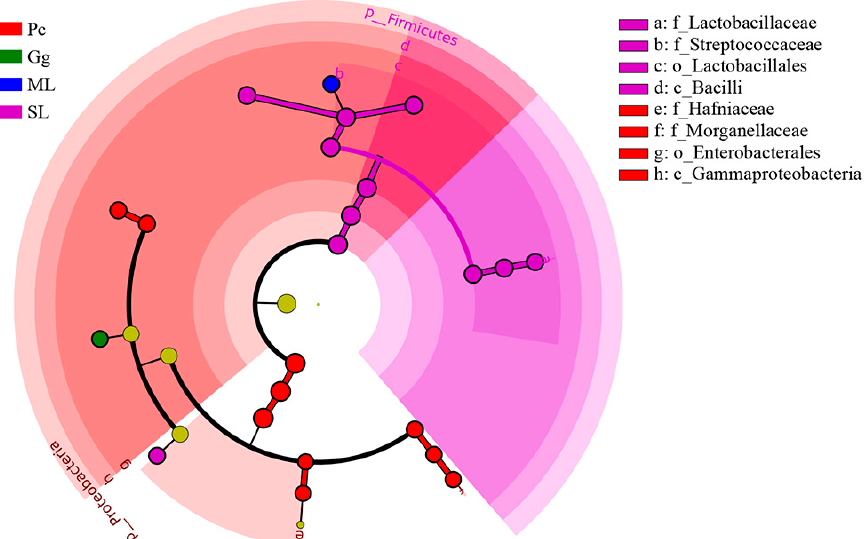
Figure 6. Cladogram of bacterial biomarkers from the phylum to genus (innermost ring to outermost ring) level, with LDA score > 4. ML: maize leaves; Gg: goosegrass; SL: soybean leaves; Pc: pakchoi. Differential bacterial taxa are marked by lowercase letters. The circles at different taxonomic levels represent a taxon at that level, and the diameter of the circle corresponds to the relative abundance. Different colors represent different groups species, with yellow representing species with insignificant differences and the other different species as the group with the highest abundance of the species.